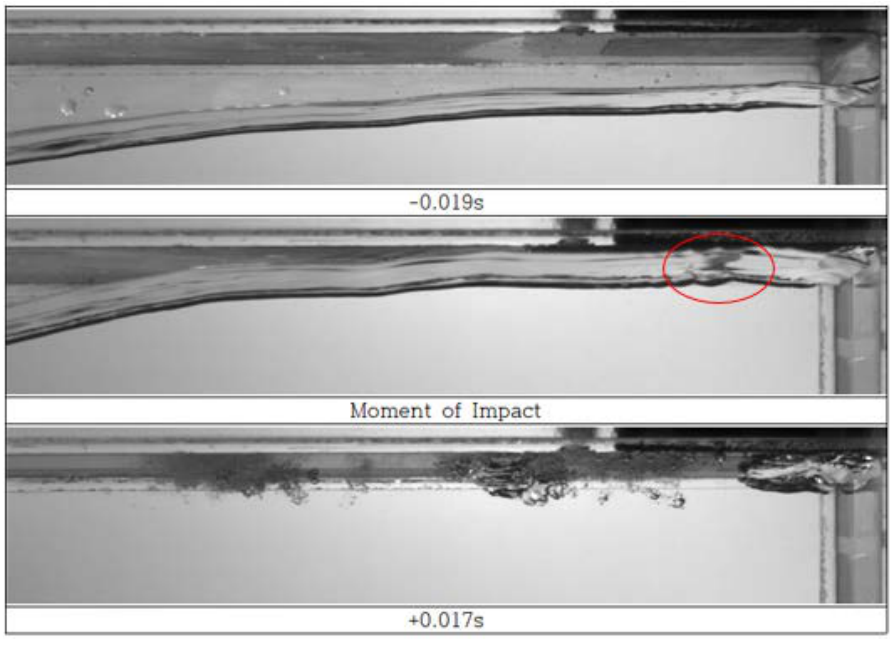
Figure 12. Snapshots at First Impact: SWAY (Dry).